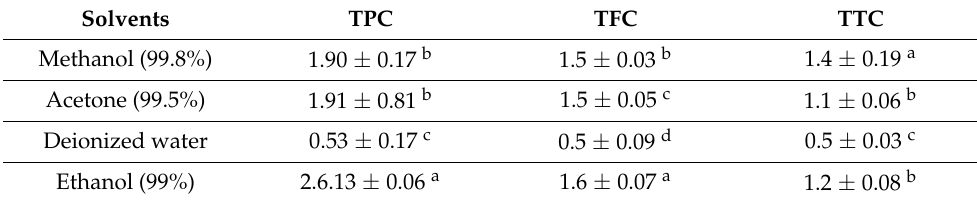
Table 2. Effect of different solvents on the extraction of TPC, TFC, and TTC from the seed extract of J. procera (mg/g